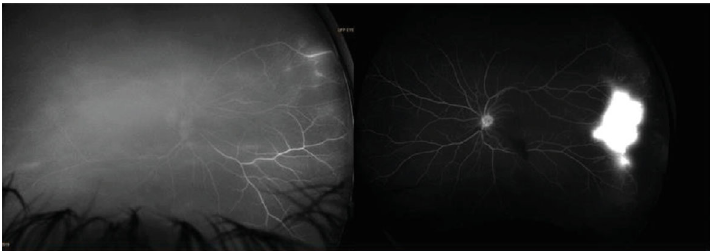
Figure 2: Fluorescein angiography showing peripheral vasculitis in the right eye and peripheral neovascularization in the left eye with signi fi cant leakage in temporal